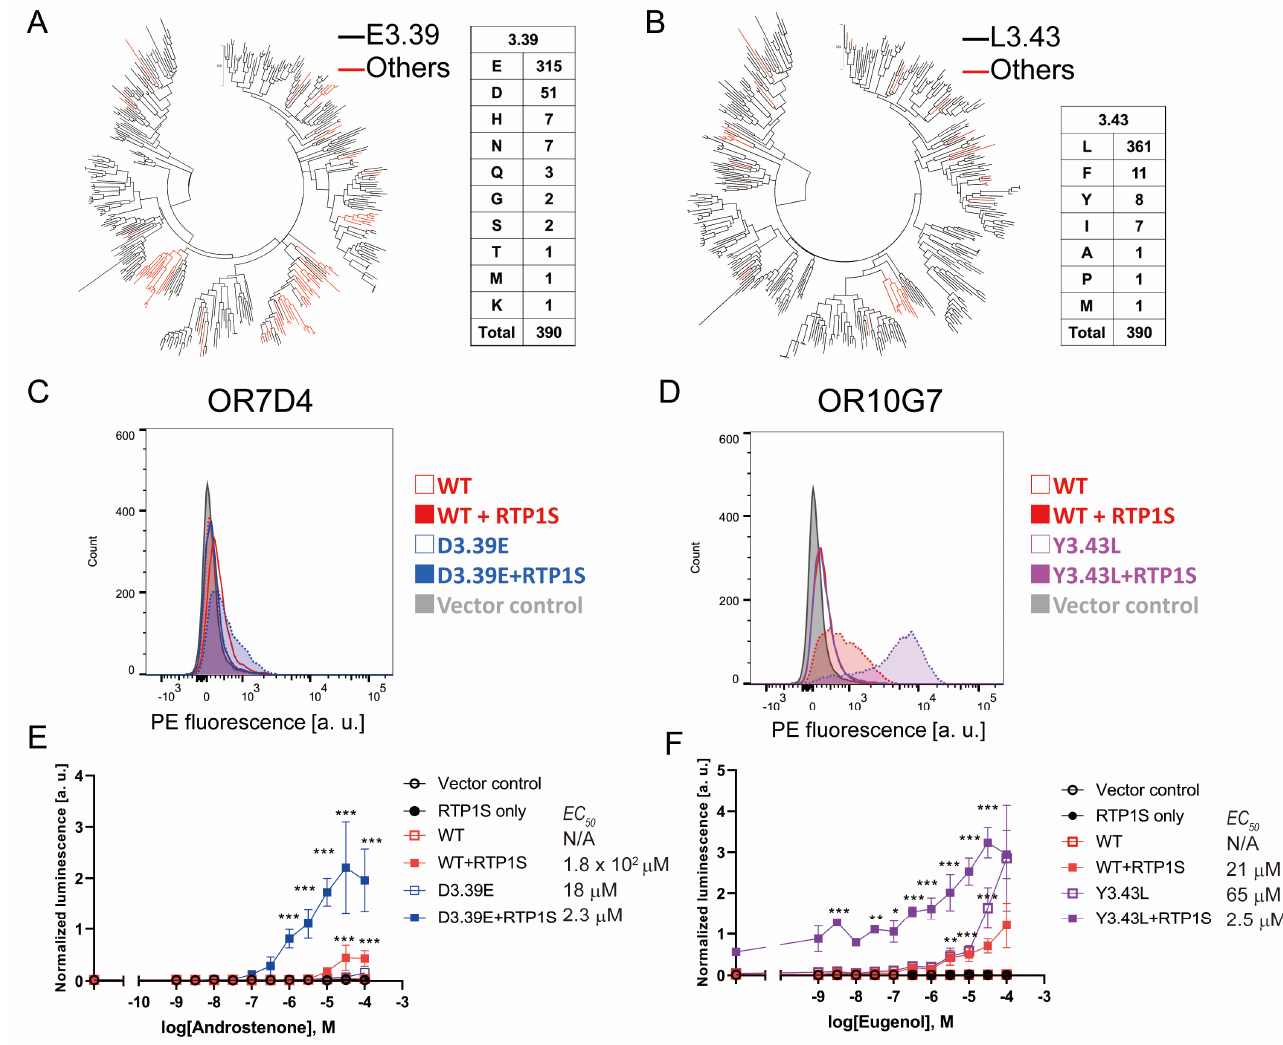
Figure 6. Effects of 3.39E and 3.43L mutants on human ORs ( A ) and ( B ) Phylogenic tree of mouse ORs showing the E3.39 or others, or L3.43 or others in 390 intact human ORs registered in the HORDE database. ( C ) and ( D ) Cell-surface expression of the Rho-tagged ORs and 3.39E mutants. Each mutant was transfected into HEK293T cells, and the cell surface expression level was measured. X-axis: PE fluorescence, Y-axis: cell number. ( E ) and ( F ) Dose response curves of OR7D4 (WT and muant) and OR10G7 (WT and mutant) to androstenone and eugenol, respectively. Error bars indicate s.e.m (n = 3). Multiple comparisons were performed using one-way ANOVA followed by Dunnett’s test (* p < 0.05, ** p < 0.01, *** p < 0.001).